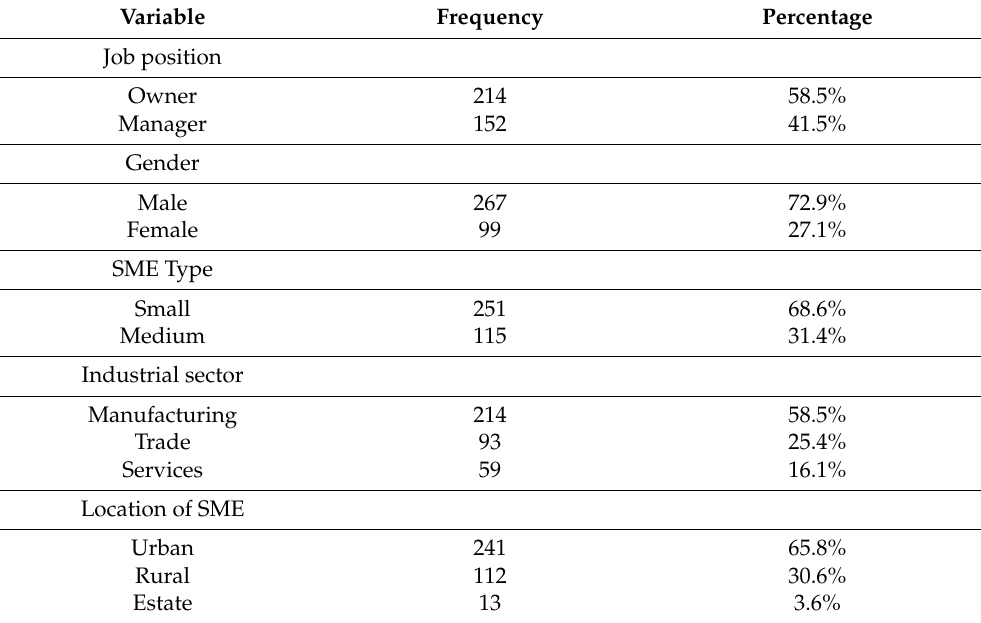
Table 1. Sample profile for categorical variable